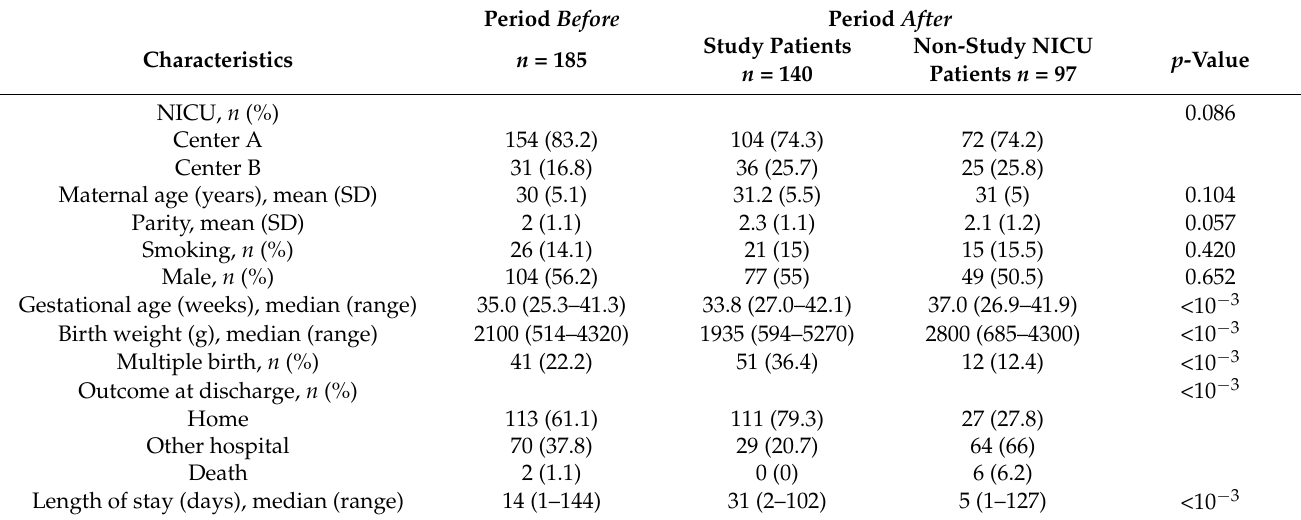
Table 3. Perinatal characteristics of neonates admitted before day 7 of life and intended to be breastfed during the period before and during the period after according to their inclusion in the Doal study.